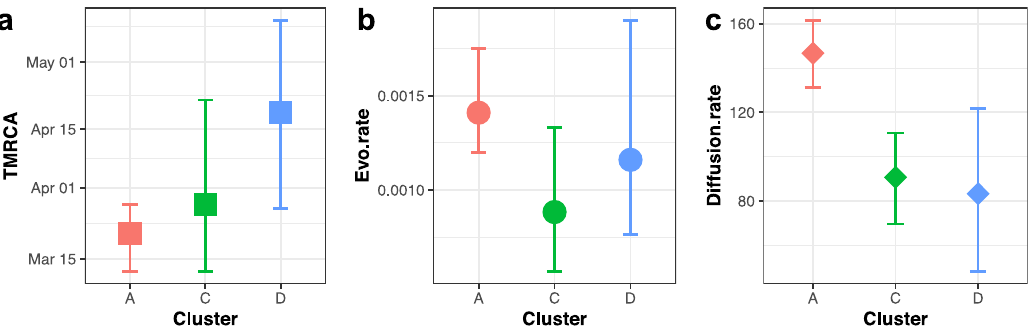
Fig. 4 Time to most recent common ancestor (TMRCA), evolution rate and spatial diffusion rate of virus clusters infecting multiple farms. Comparisons of Cluster A, C and D in TMRCA (month, year) ( a ), evolution rate (substitution/site/year) ( b ) and spatial diffusion rate (km/year) ( c ). Data are presented as means(square, circle and diamond) and 95% highest posterior density (HPD) intervals (error bars), estimated with Bayesian phylogenetic methods with MCMC algorithm (with a chain length of 1 × 10 8 steps sampling every 1 × 10 4 steps). Cluster A, C and D are in red, green and blue, respectively.